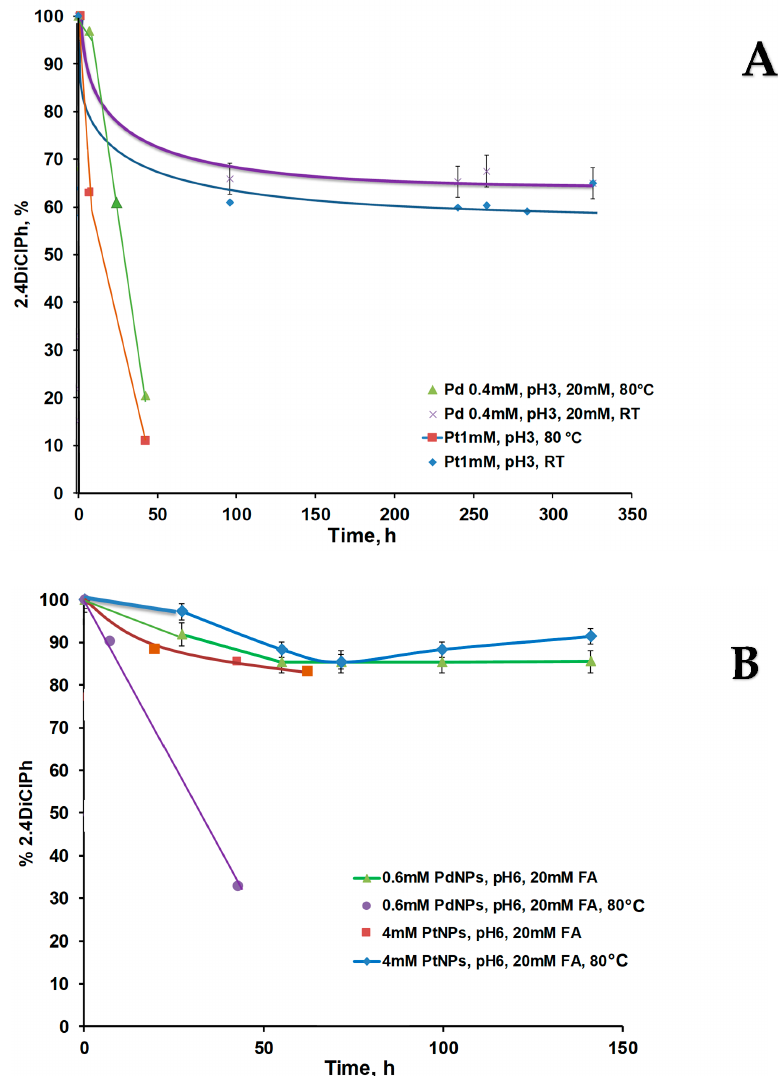
Figure 10. Kinetic curves of 2,4DiClPh de-chlorination process in batch mode in the presence of CHI-GA-PdNPs and CHI-GA-PtNPs cryogels at room temperature or at 80 °C The mixture of 2,4DiClPh (65.2 ppm) and formic acid (20 mM) at: ( A ) pH 3 and; ( B ) pH 6.2.